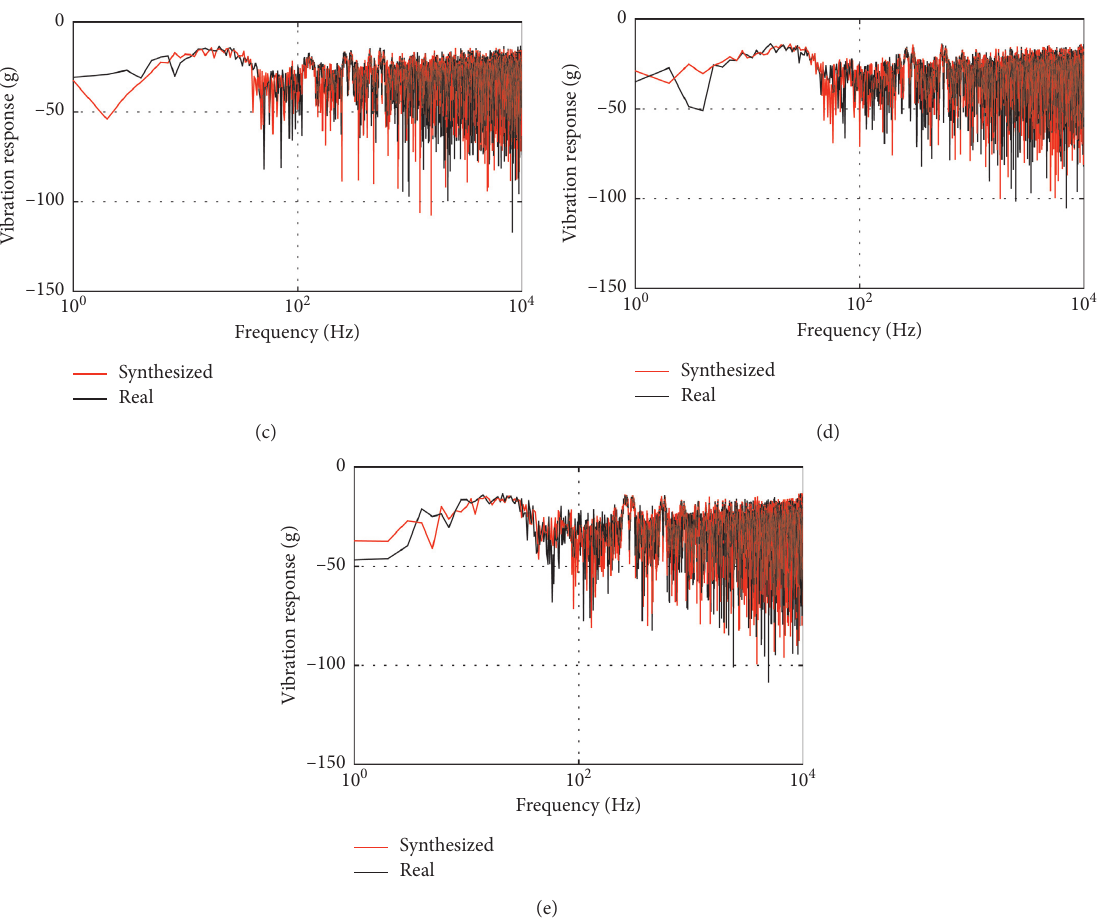
Figure 17: Total response synthesis in function of the correlation factor: (a) correlation � 20%; (b) correlation � 40%; (c) correlation � 60%; (d) correlation � 80%; (e) correlation � 100%.